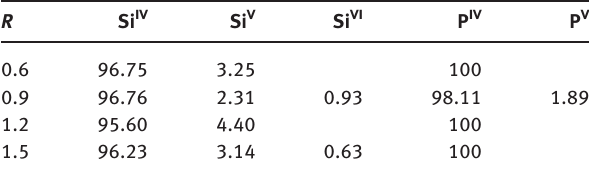
Table 3: Coordination statistics of Si and P, %.